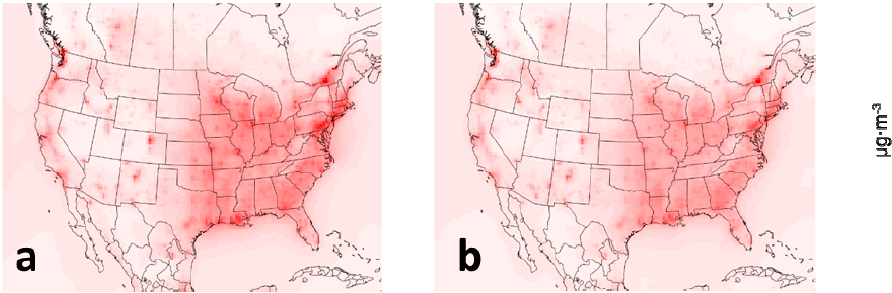
Figure 3. Mean PM 2.5 concentrations across the domain for ( a ) 2020 and ( b ) 2050 in µ g m − 3 .